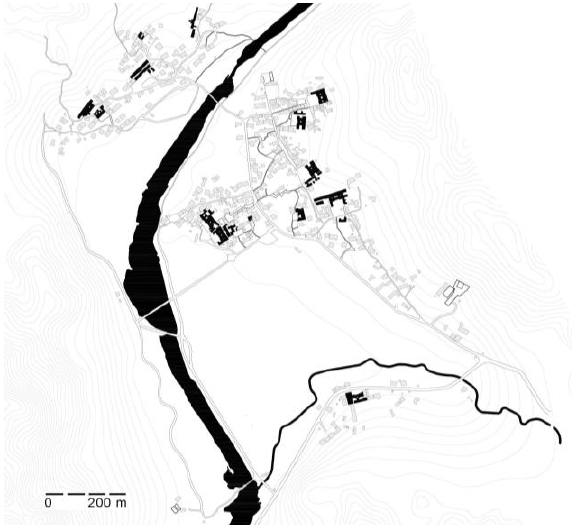
Figure 3. The fifteen ancestral halls. Elaboration by the first author.